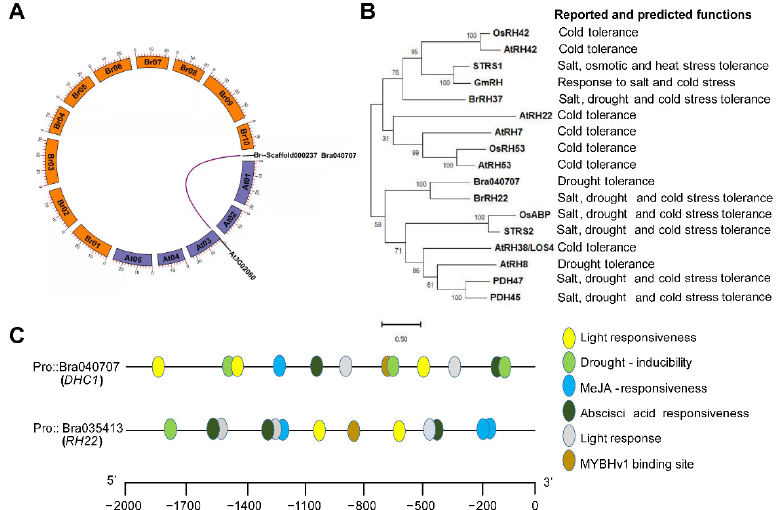
Figure 1. Collinear and phylogenetic analysis of DHC1 genes, and cis -acting elements analysis of the promoters of the Dead-box helicases. ( A ) Collinearity of the DHC1 gene between Arabidopsis thaliana and Brassica rapa . ( B ) Phylogenetic tree of the DEAD-box helicases from different species, constructed by MEGA 11. ( C ) The distribution of cis -acting regulatory elements on the promoters of BrDHC1 and BrRH22 genes.